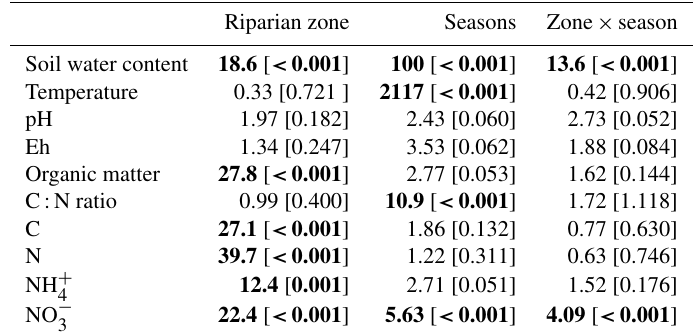
Table 2. Results from the mixed-model analysis of variance (ANOVA) showing the effects of riparian zones and seasons on soil water content, soil temperature, soil pH, soil redox capacity (Eh), soil organic matter, soil molar C:N ratio, soil carbon (C) and nitrogen (N) content, and soil ammonium (NH + ) and nitrate (NO − ) concentrations. Plot was treated as a random effect in the model, whereas riparian zones, seasons, 4 3 and their interactions were considered fixed effects. Values are F values and the p values are shown in brackets. P values < 0 . 05 are shown in